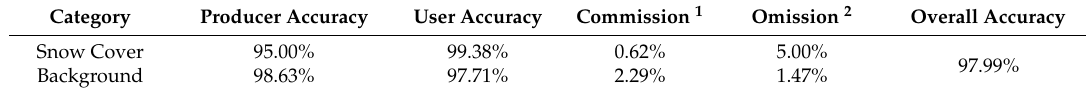
Figure 14. Distribution of snow cover mapped by the RSI method from the GF-4 PMS image: ( a ) test site No. 1; ( b ) test site No. 2. The two subfigures have the same north arrow, scale, and legend, which are marked on the upper part of the figure. Table 5. Classification accuracy of the validation dataset.